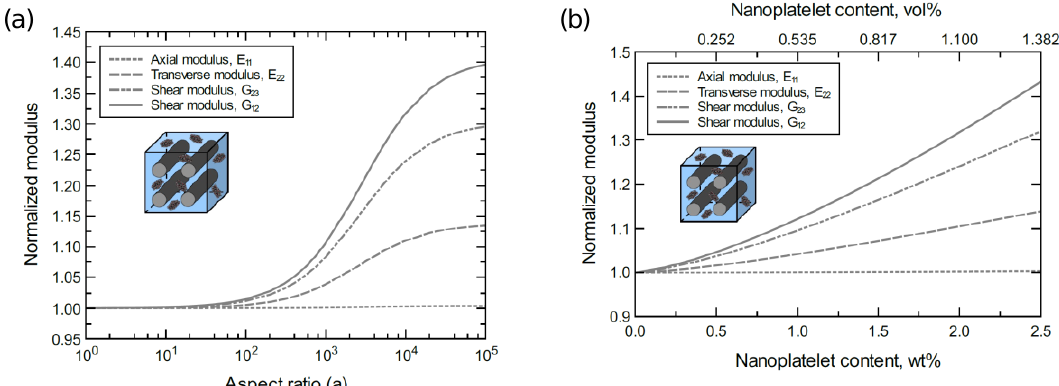
Figure 6. Normalized elastic and shear moduli for unidirectional CF/4GNP/epoxy ( a ) at 1.0 wt% of 4GNP and various 4GNP aspect ratios, ( b ) at 10 3 4GNP aspect ratio and various 4GNP contents. The volume fraction of CF is 56%.